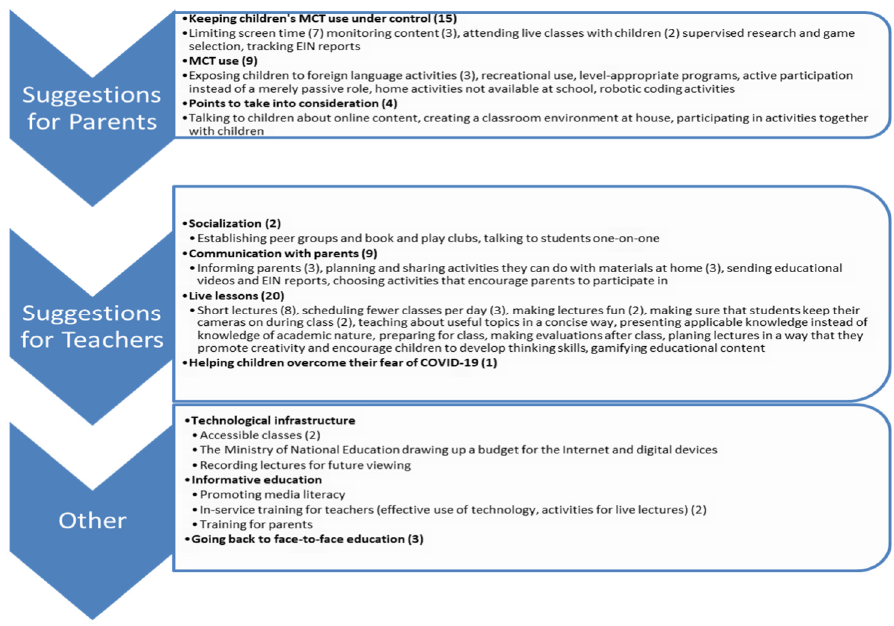
Figure 5 : Suggestions for Using MCTs for Educational